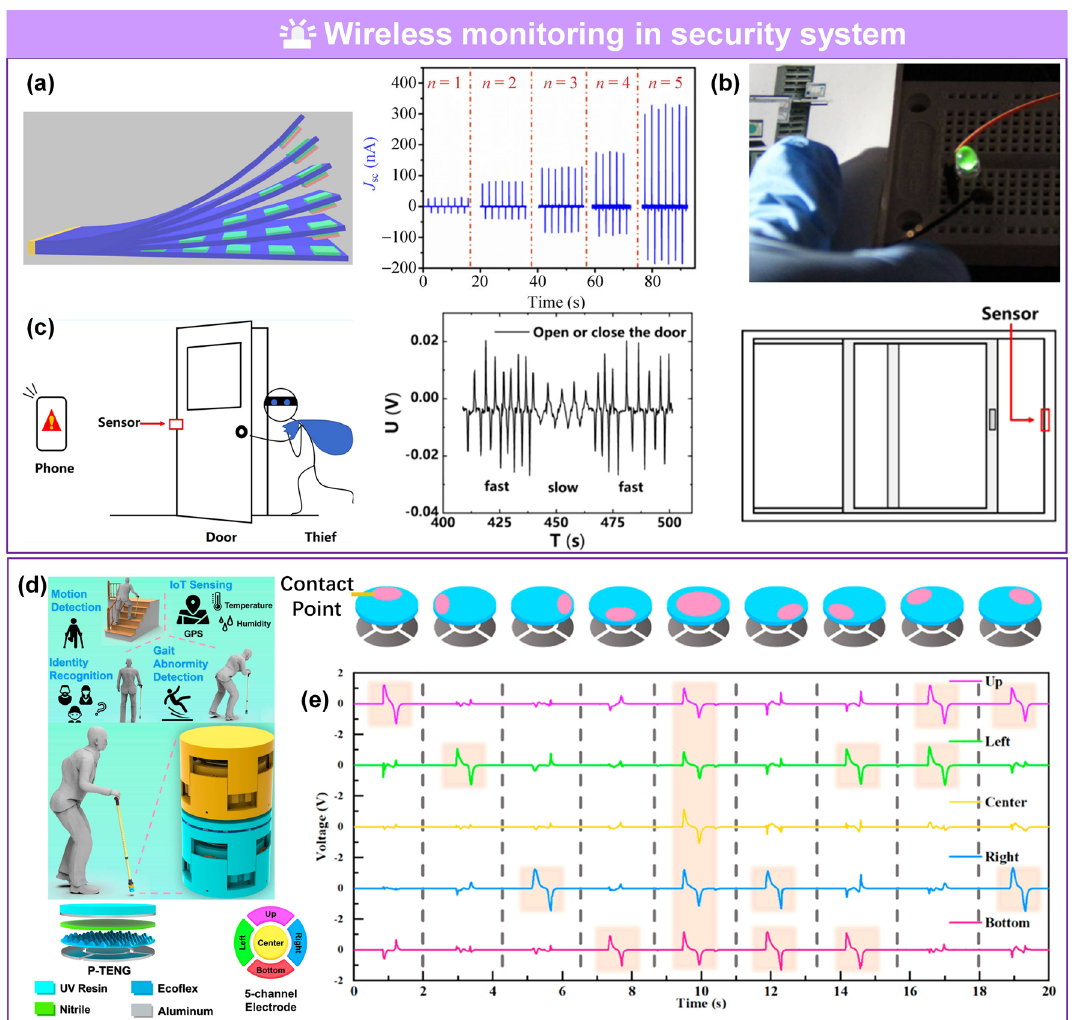
Fig. 19 Application for wireless monitoring in security. a‑b Page mark and theft-alarm system [23]. Copyright (2014) Springer Nature. c Anti- theft system for monitoring of door and window [53]. Copyright (2020) American Chemical Society. d‑e Caregiving walking stick for locating and motor monitoring [17]. Copyright (2021) American Chemical